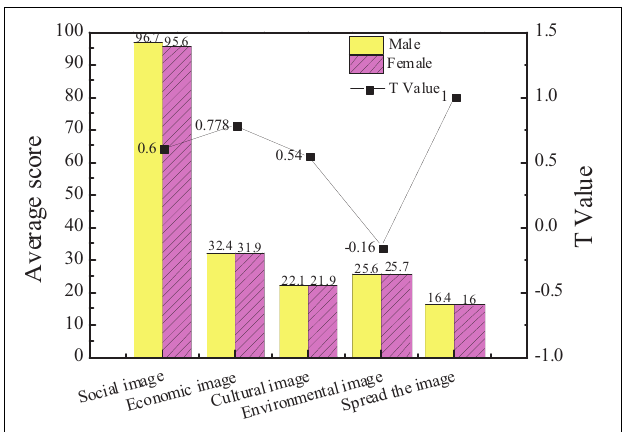
FIGURE 4 | Comparison of the attention of the entrepreneurs with different educational backgrounds to the city image.